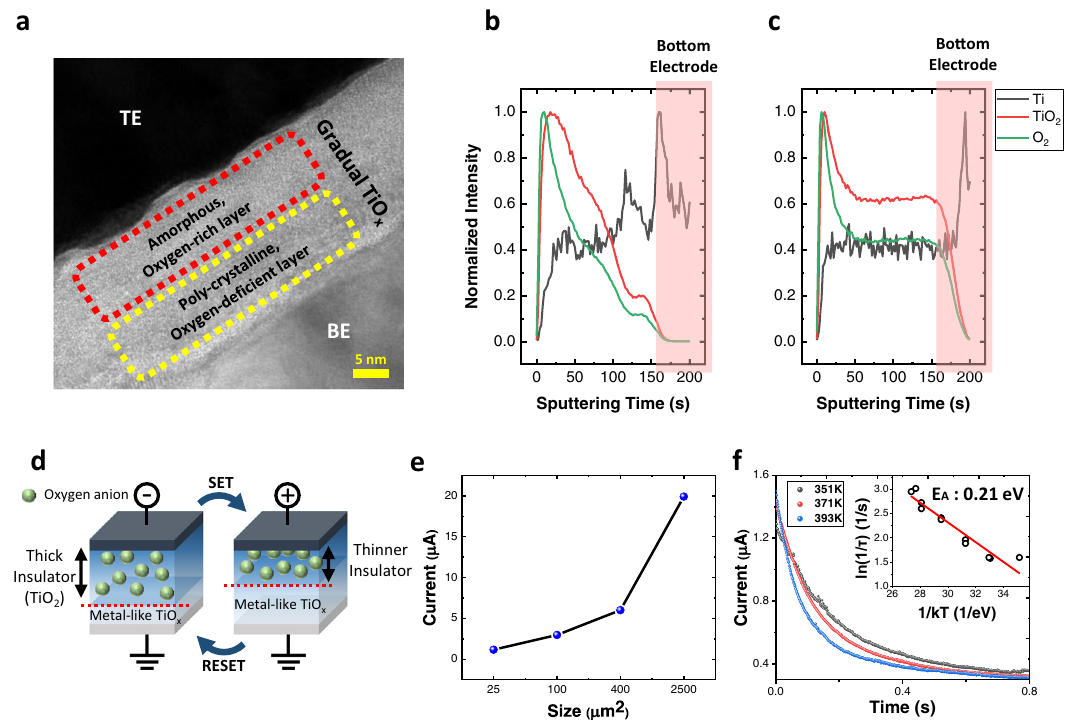
Fig. 2 Effects of gradual oxygen concentration in TiO x switching layer. a A cross-sectional TEM image of the gradual TiO x memristor. b TOF-SIMS depth pro fi le results of anodized TiO x . c TOF-SIMS depth pro fi le results of sputtered TiO 2 . d A schematic representation of the switching mechanism of the gradual TiO x memristor. e Size dependency of the gradual TiO x memristor. The memristors with four different sizes (5 × 5, 10 × 10, 20 × 20, and 50 × 50 [ µ m 2 ]) are fabricated on the same wafer. The current is measured at 1 V at a low resistance state (LRS) during the linear voltage sweep from 0 V to 4 V. f An activation energy (E A ) calculated from the time constant under various temperatures. The time constant decreased when the temperature increased, and the activation energy calculated from the change of the decay time along the temperature implies that the resistive switching and short-term dynamics originate from the oxygen anions in TiO x